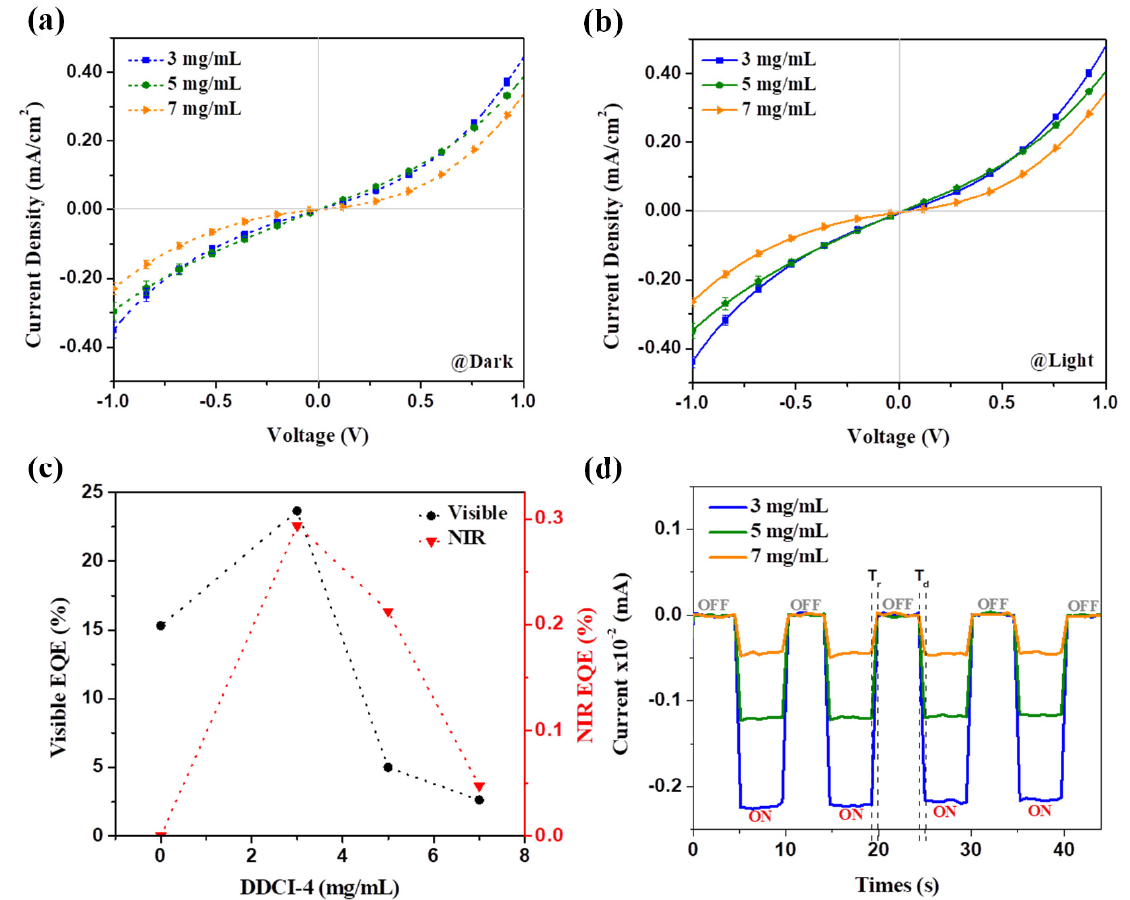
Figure 4. Current density–voltage characteristics of P3HT:DDCI-4:OXCBA devices under ( a ) dark; ( b ) light illumination at − 1 V; ( c ) External Quantum Efficiency (EQE) spectrum; ( d ) photo-response behavior of devices. Table 3. Photo-sensing characteristics of P3HT:DDCI-4:OXCBA blended devices of different ratios at − 1V.